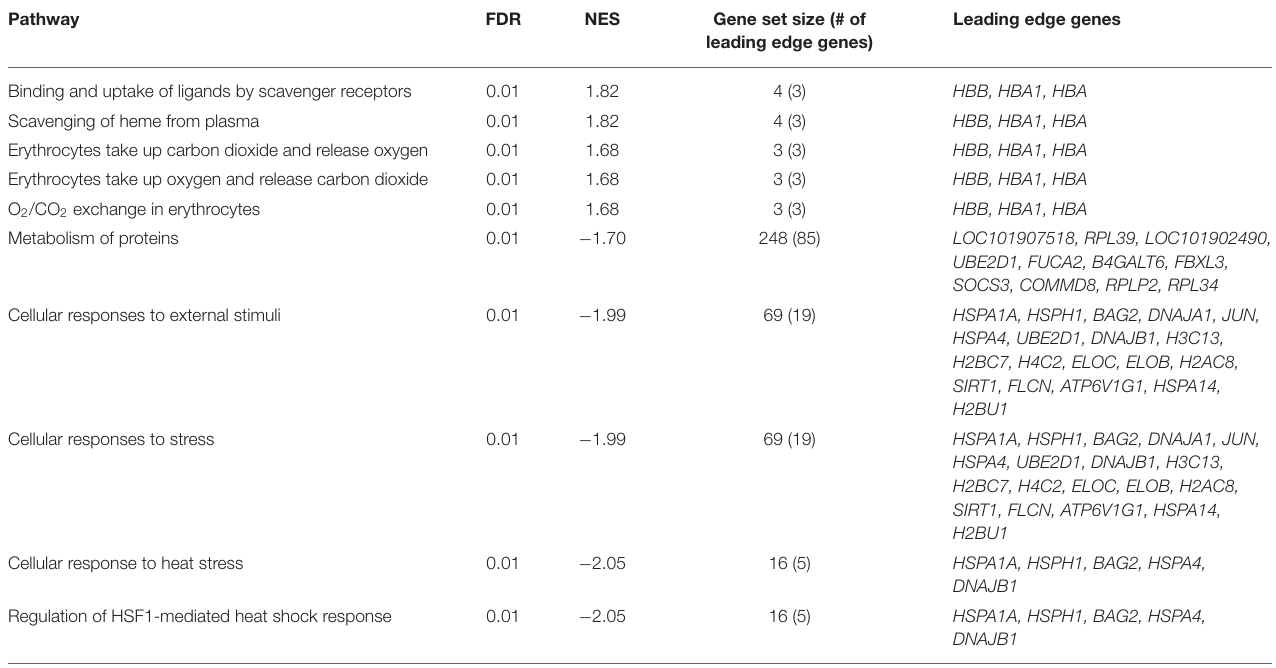
Leading edge genes leading edge genes)